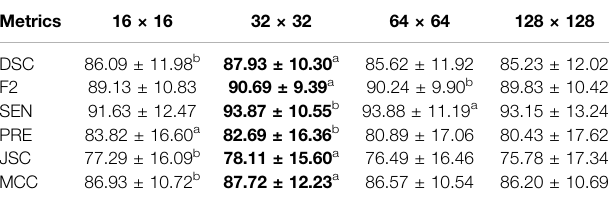
a ranked fi rst. b ranked second. Note: Bold values represent the best results in the